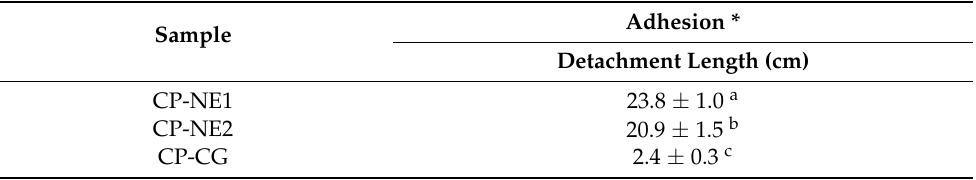
Figure 3. TEM images of CP-NE compared to BL-NE at magnification of 10,000×. Table 4. Adhesion properties of CP-NE formulations in comparison with the commercial bleaching gel (CP-CG).